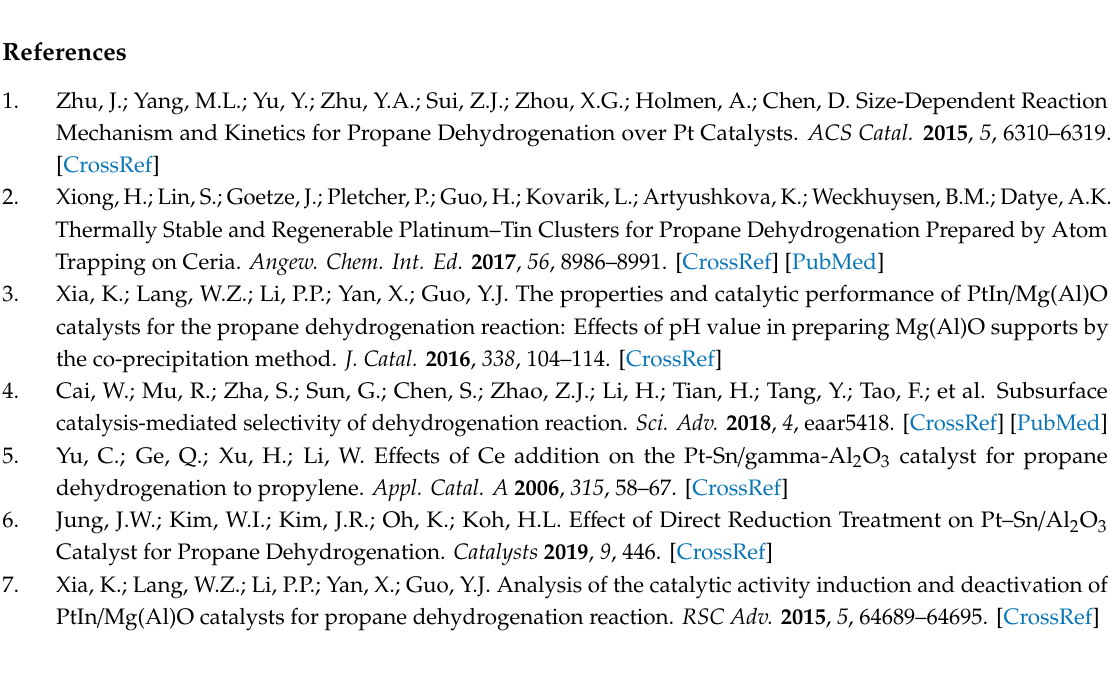
Figure S1: Propane conversion and propene selectivity as function of time for blank tube, Figure S2: The selectivity of methane, ethane and ethene as function of time for di ff erent